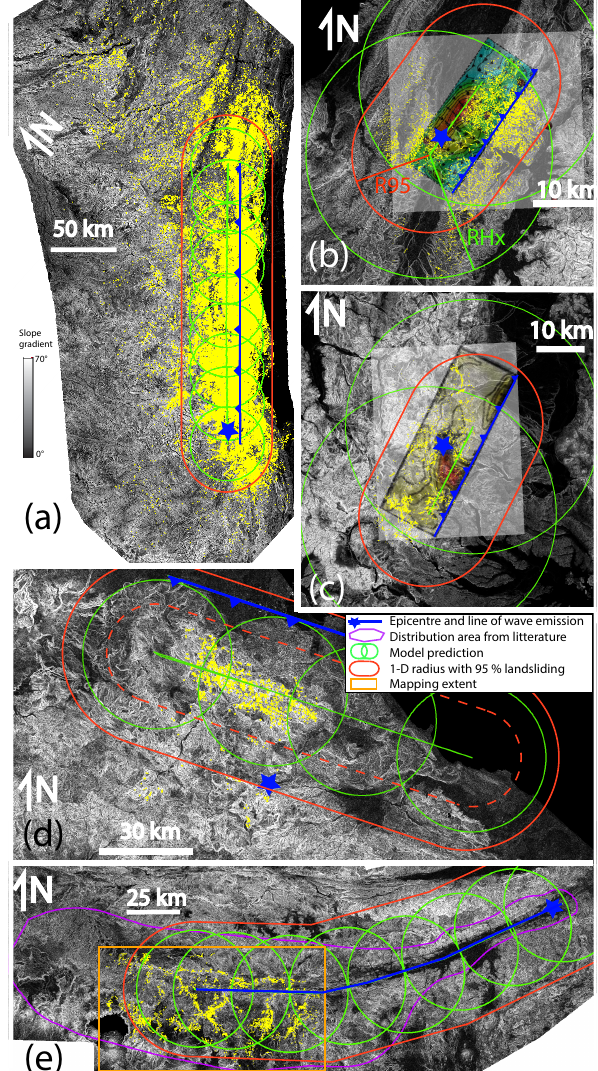
Figure 4. Same as Fig. 3 for the Wenchuan (a) , Niigata (b) , Iwate (c) , Limon (d) , and Guatemala (e) earthquakes. For reference, rupture slip distribution maps are shown for the Niigata and Iwate earthquakes (Hikima and Koketsu, 2005; Suzuki et al., 2010). Ad- ditionally, the distribution area proposed by Harp et al. (1981) for the Guatemala earthquake is shown in purple. For the Limon earth- quake, the total area of landslides is likely underestimated in the most affected area and therefore R 95 is likely reduced and more similar to the dashed red